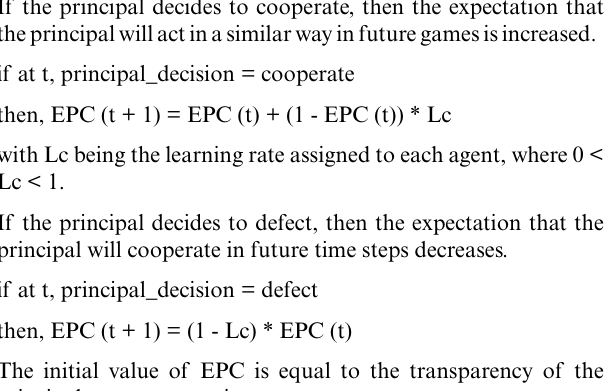
Fig. 4 . Relation between agent’s learning and